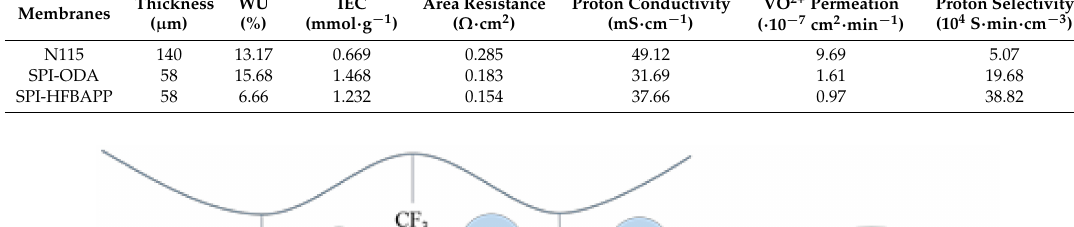
Table 1. Physicochemical property of N115 and SPI membranes Thickness Membranes ( µ